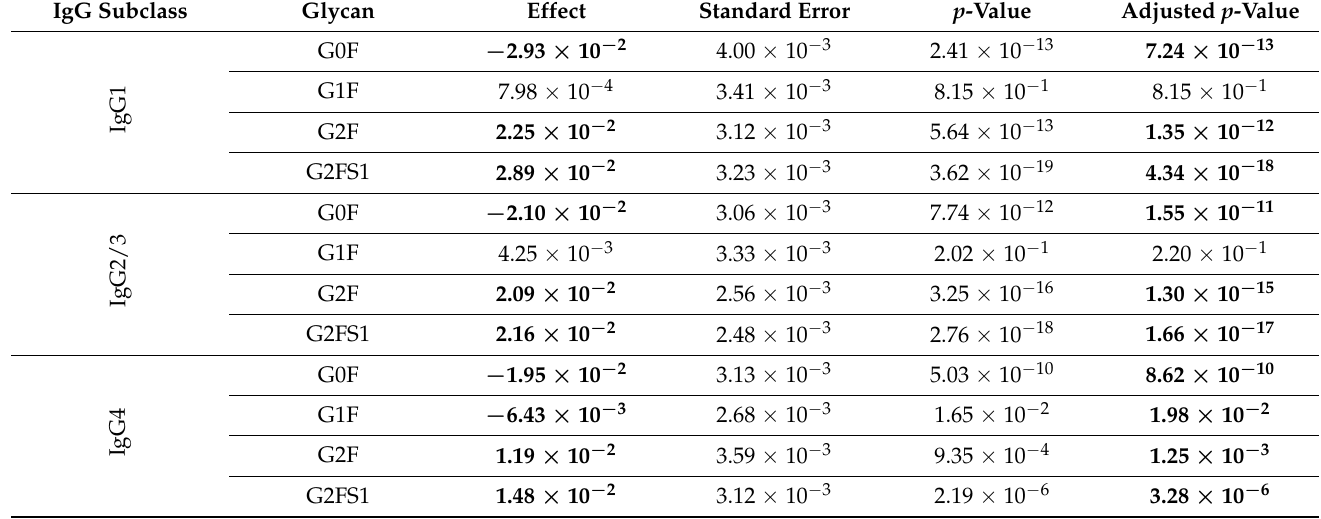
Table 1. Changes in IgG Fc glycan profiles during therapy in three cohorts of UC and CD patients: meta-analysis (Cohort 1–26 weeks, Cohort 2–30 weeks, and Cohort 3–14 weeks on therapy). p -values were adjusted for multiple testing and considered significant if <0.05 (bold). Effect: model coefficient (slope) representing the weekly change of a glycan trait (expressed in standard deviation units). Changes in IgG1 Fc glycan patterns during treatment for individual cohorts are visualized in Figure 2 and results of statistical analysis for individual cohorts are shown in Table